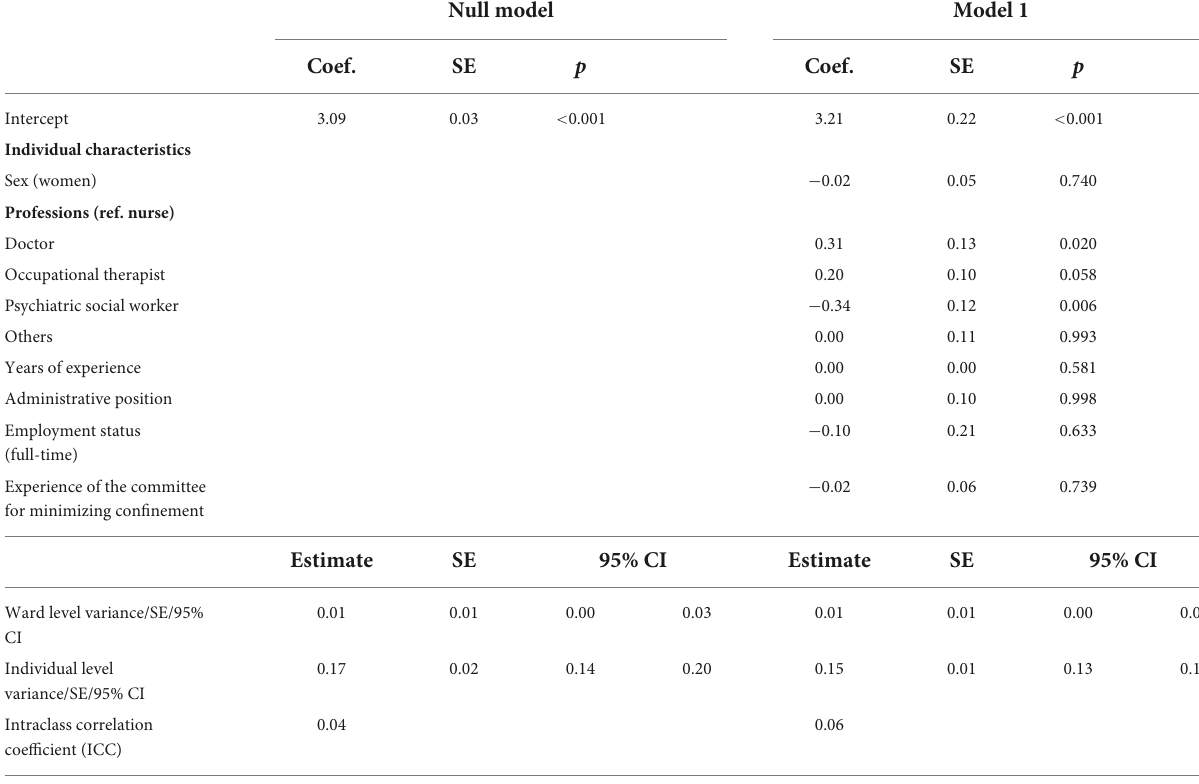
TABLE 4A Ward level variance of the SACS score using multilevel linear regression analyses ( N = 255, 17